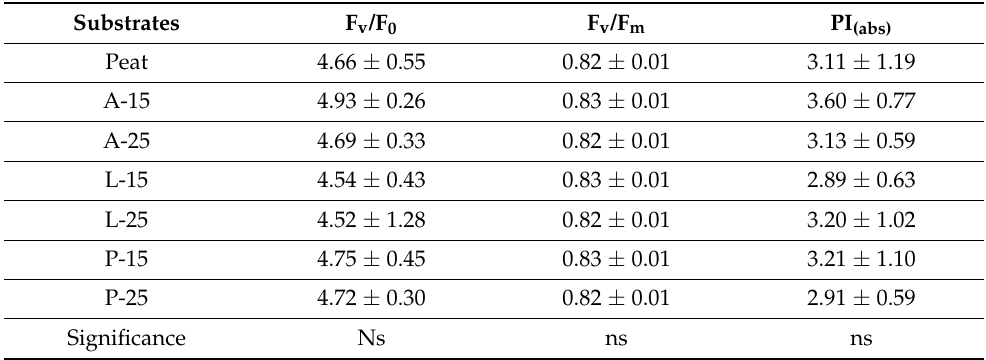
Table 10. Selected chlorophyll fluorescence parameters of strawberry cv. ‘Honeoye’ cultivated in different substrates (mean ±